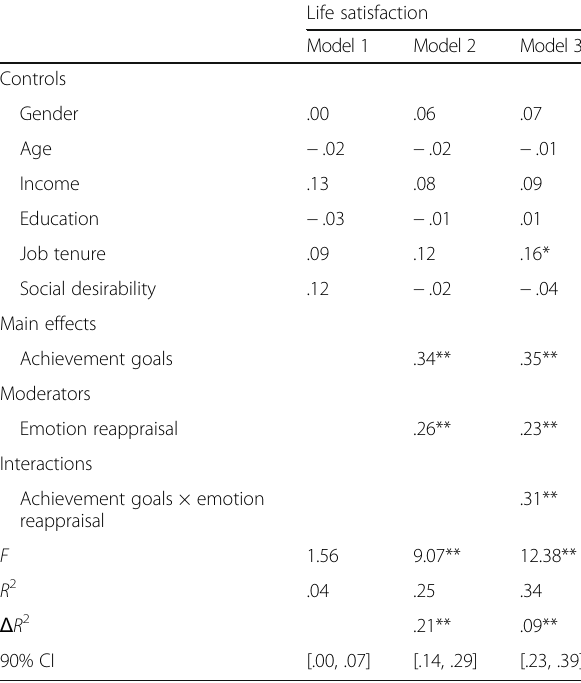
Table 4 Results for moderation from hierarchical